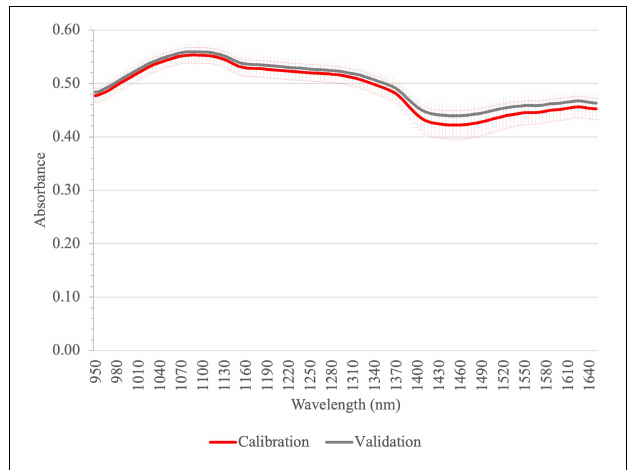
FIGURE 3 | Average absorbance spectra of homogenized tomato fruit samples for calibration and validation in SWIR by Perten; vertical bars represent the standard deviation (calibration n = 144; validation n =